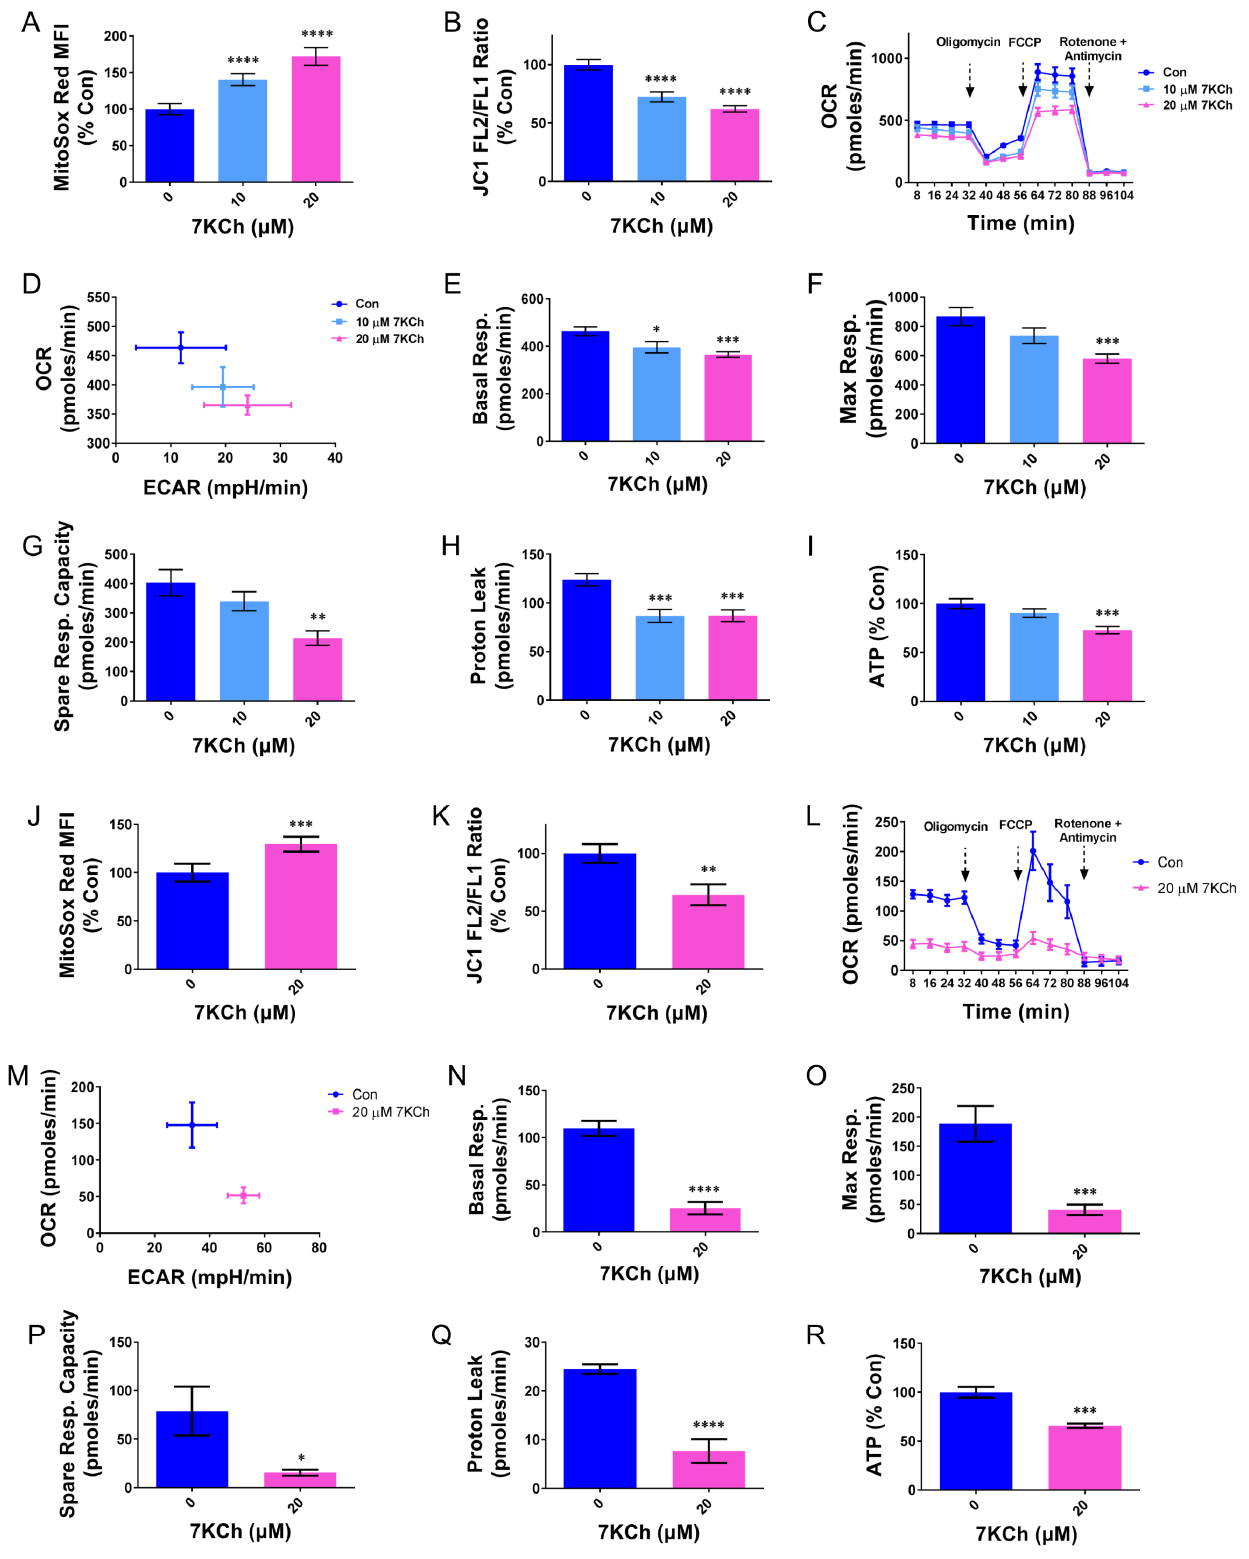
Figure 2. Mitochondrial dysfunction in cardiomyocytes is caused by 7KCh. HL-1 ( A – I ) and AC16 ( J – R ) cells were treated with the indicated concentrations of 7KCh for 24 h and stained with MitoSOX red ( A , J ) or JC1 ( B , K ). The mean fluorescence intensity (MFI) of the MitoSOX red-stained cells is expressed as the percentage relative to that of the untreated control ( A , J ). The ratio of the MFI of